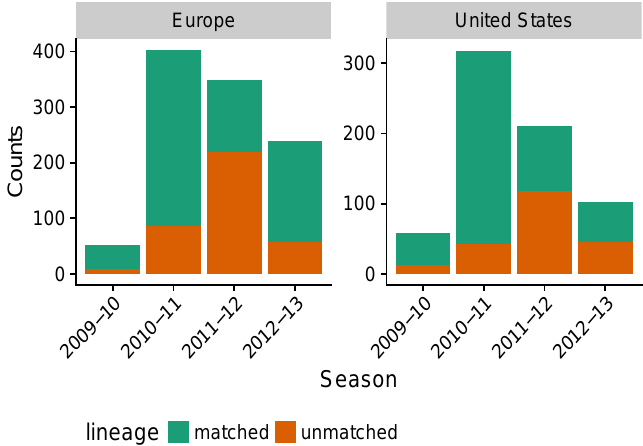
Figure A15. Seasonal counts of influenza B sequences contained in the GISAID database. Colors represent lineages that are matched or unmatched to the vaccine strain in the trivalent inactivated vaccine. These data are used in the influenza B lineage-level analysis of vaccine-driven selection.